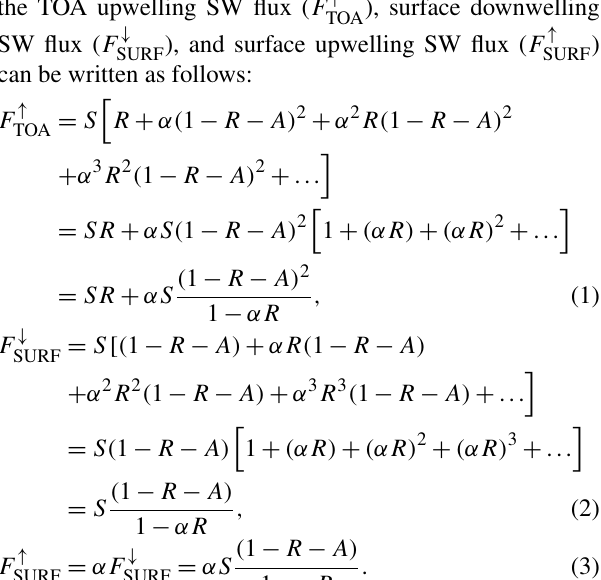
Table 2. Models participating in GeoMIP G4 experiments and used in this study. Manners of simulating sulfate aerosol optical depth (AOD), particle sizes, and standard deviation of their log-normal distribution ( σ ), and ensemble members are shown for each model. Models Sulfate AOD Particle size Ensemble BNU-ESM; Ji et al. (2014) Prescribed 0.426 (1.25) 1 CanESM2; Arora and Boer (2010), Arora et al. (2011) Uniform 0.350 (2.0) 3 HadGEM2-ES; Collins et al. (2011) Internally calculated MIROC-ESM; Watanabe et al. (2011) Prescribed 0.243 (2.0) 1 MIROC-ESM-CHEM; Watanabe et al. (2011) Prescribed 0.243 (2.0) 9 MIROC-ESM-CHEM-AMP; Watanabe et al. (2011), Sekiya et al. (2016) Internally calculated 0.243 (2.0)